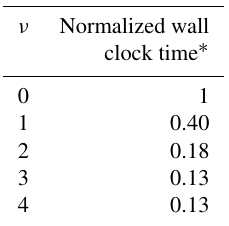
Table 2. Normalized wall clock time versus maximum offspring generations ( ν ) for the UBER 3D solutions at T = 0 .